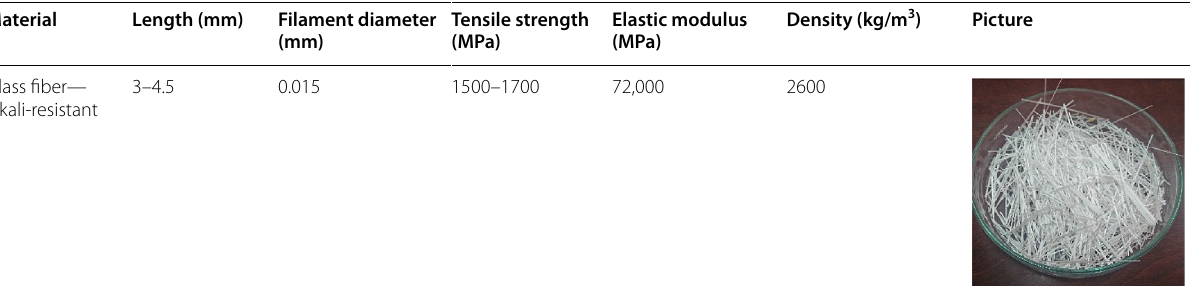
Table 3 Properties of fiber